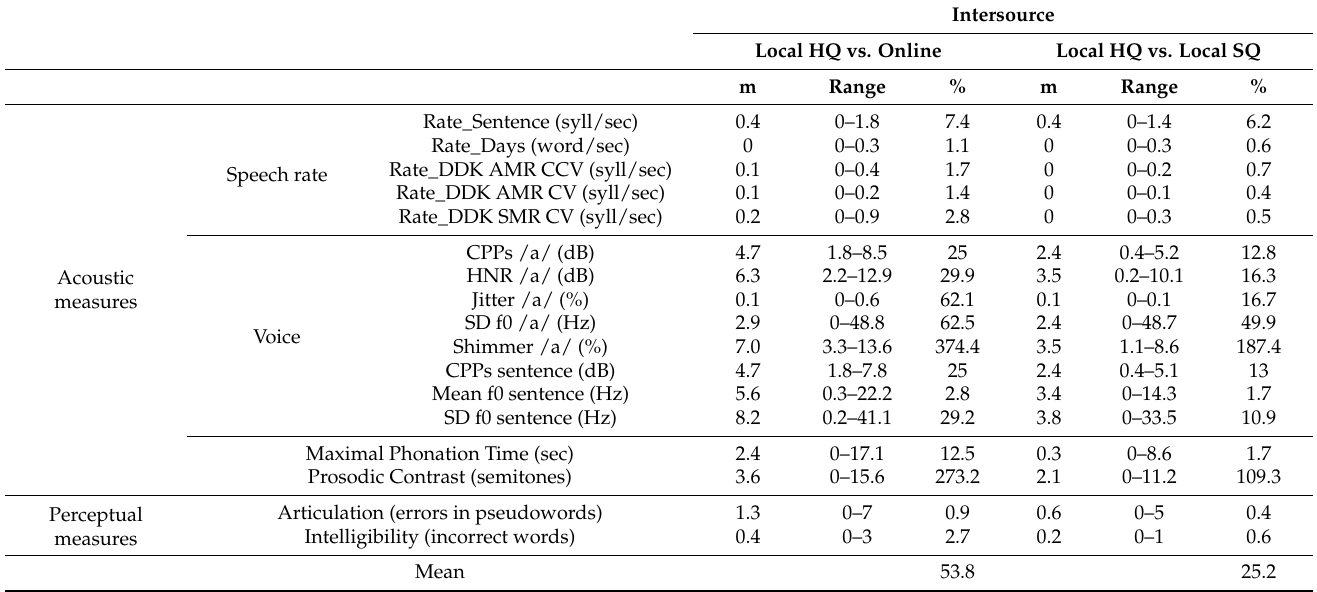
Table 3. Mean raw differences (units in brackets), range of raw differences and mean ratio of divergence (%) between sources (with the local HQ condition serving as baseline reference). Intersource Local HQ vs. Online Local HQ vs. Local SQ m Range % m Range %